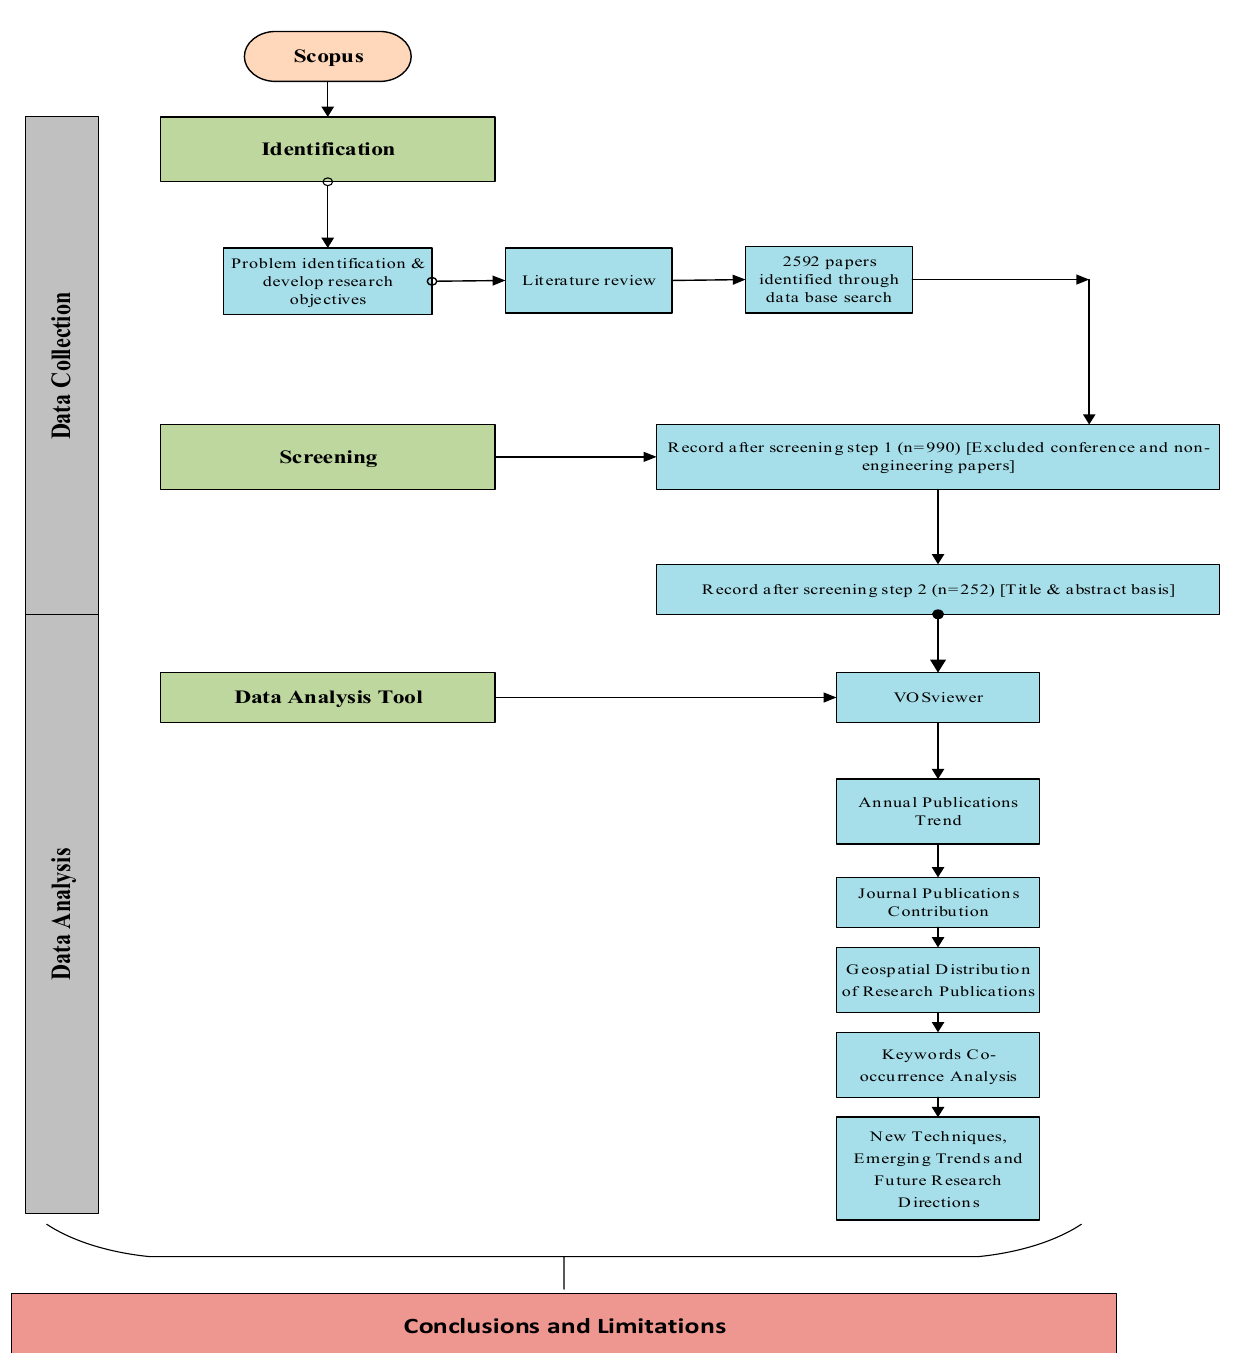
Figure 1. Research methodology flowchart.